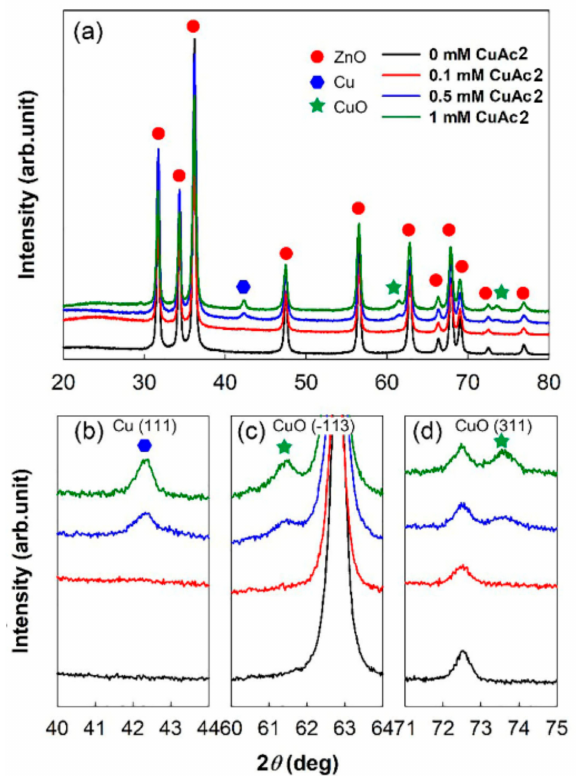
Figure 5. ( a ) XRD spectra of Cu / CuO@ZnO HNFs with di ff erent concentrations of CuAc 2 ; ( b ) enlarged XRD spectra in a 2-theta range of 40 ◦ –44 ◦ ; ( c ) enlarged XRD spectra in the 2-theta range of 60 ◦ –64 ◦ ; ( d ) enlarged XRD spectra in the 2-theta range of 71 ◦ –75 ◦